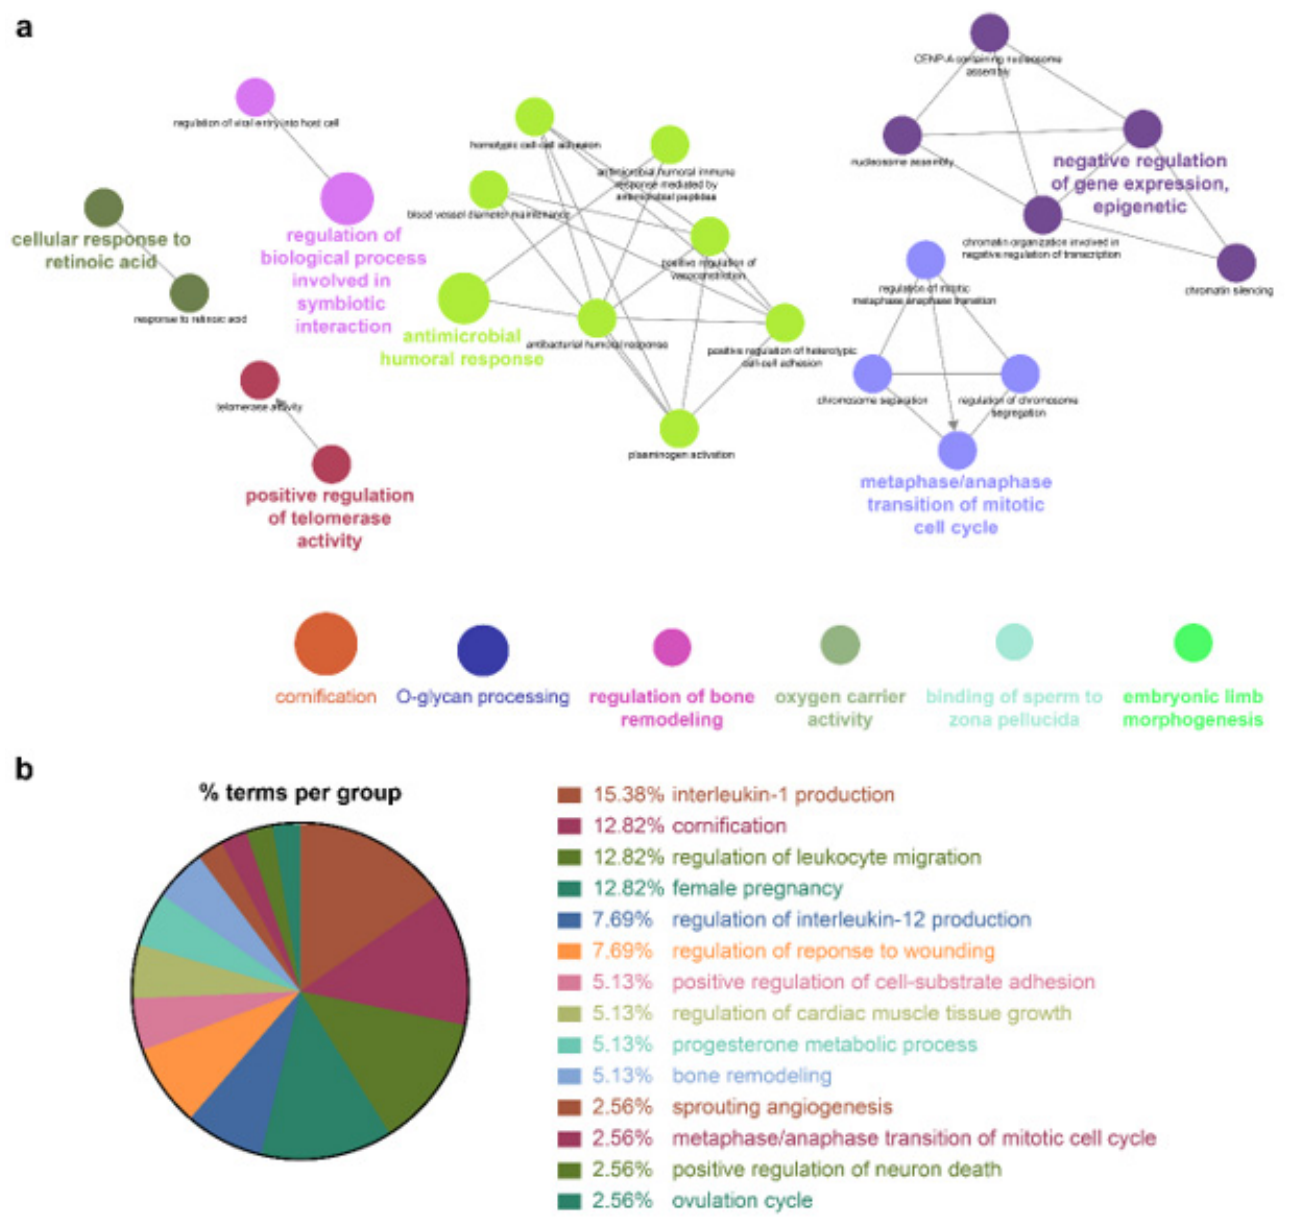
Figure 4. GO enrichment and pathway analysis of NSCLC features. ( a ) Visualized networks of enriched GO “Biological Process” terms of NSCLC were grouped based on shared genes (Kappa score threshold = 0.4). Enriched terms by p value corrected with Bonferroni were retained as the functional description. The node size is proportional to the degree of significance. ( b ) % terms per group represents the proportion of GO terms in the NSCLC features.